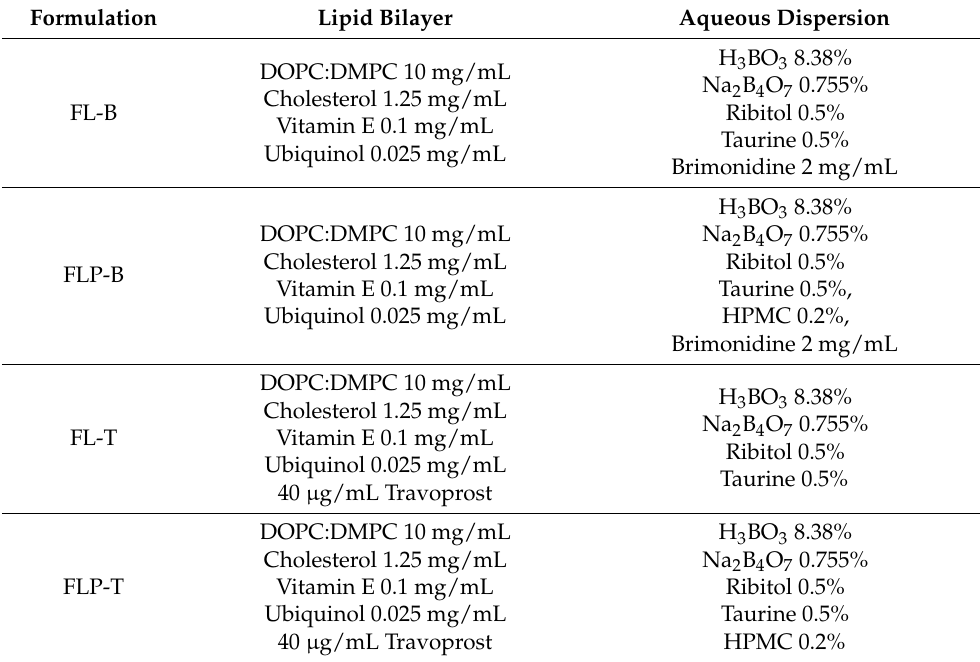
Table 1. Composition of the different liposomal formulations prepared.